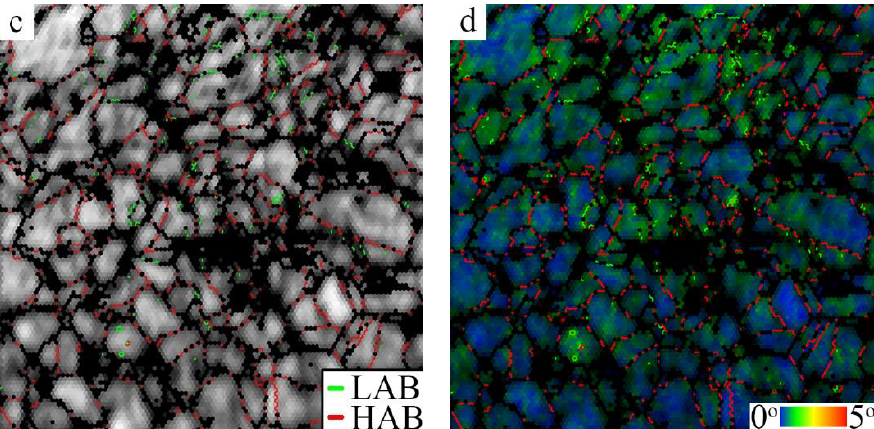
Figure 6. EBSD color-coded maps corresponded to the working part of the specimen after tensile test to 900% elongation at 950 °C and the strain rate of 4.2 × 10 −4 s −1 : grain map ( a ), phase map and [001] inverse pole figure for austenitic phase ( b ), grain boundary map combined with image quality map ( c ), and Kernel average misorientation map combined with boundary map ( d ). All maps were constructed for the austenitic phase (normal direction) with CI > 0.3 and step size 0.3 µm. LAB–low- angle boundaries, HAB–high-angle boundaries. The EBSD maps for transverse and rolling directions were similar to maps in ( a – d ).